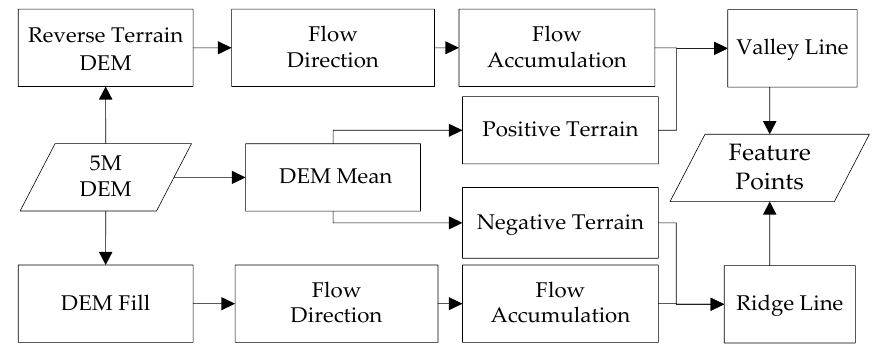
Figure 4. Feature points extraction flowchart.